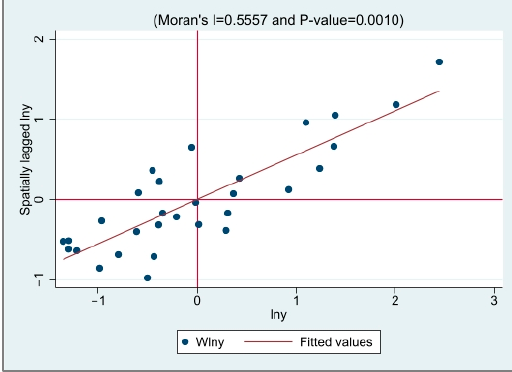
Figure 2. The scatter plot of the Moran index of EG in 2019.